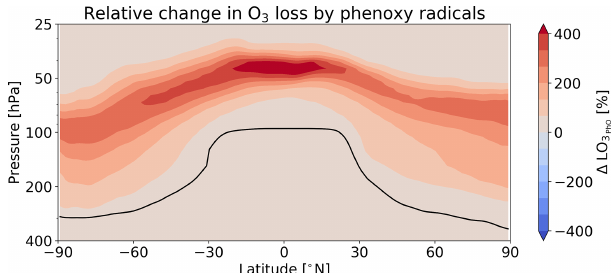
Figure 14. Zonal mean relative change in the destruction of O 3 by phenoxy radicals (Reaction R2) due to VOC biomass burning emis- sions (FIR vs. REF) in April 2016. The tropopause pressure level is indicated in